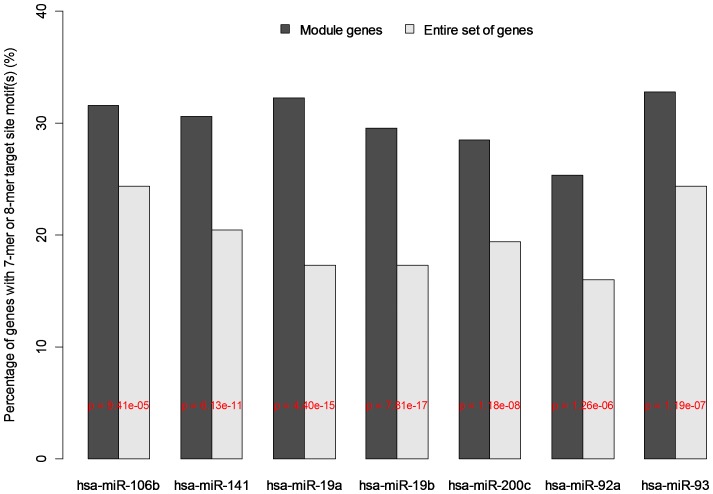
miRNA target site enrichment analysis for module p-modu-5-ne.